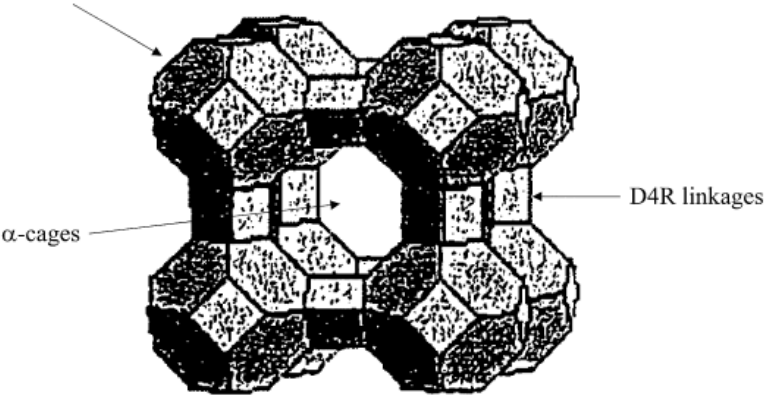
Fig. 1. Repeating unit of zeolite NaA